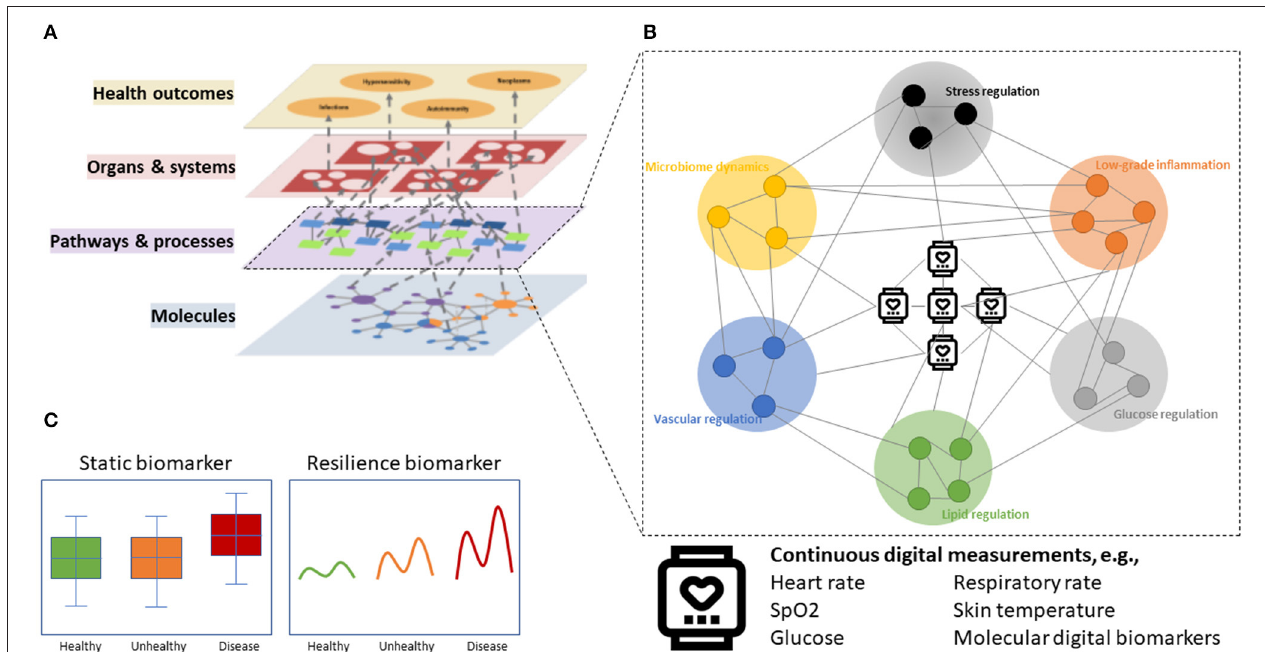
FIGURE 1 | Conceptualization of digital resilience biomarkers. (A) The multilayer model of health with complex interactions across hierarchical layers of biological organization. (B) Digital sensors can be connected to molecules or biological processes of, e.g., glucose regulation, lipid regulation, vascular regulation, microbiome dynamics, stress regulation, and low-grade inflammation to come to a digital resilience biomarker. (C) Resilience markers are more sensitive to early and subtle derailments of biological system before disease manifests.